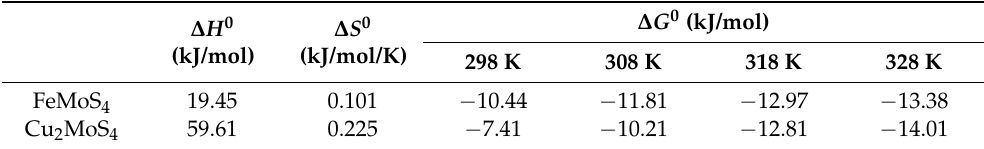
Table 4. Adsorption thermodynamic